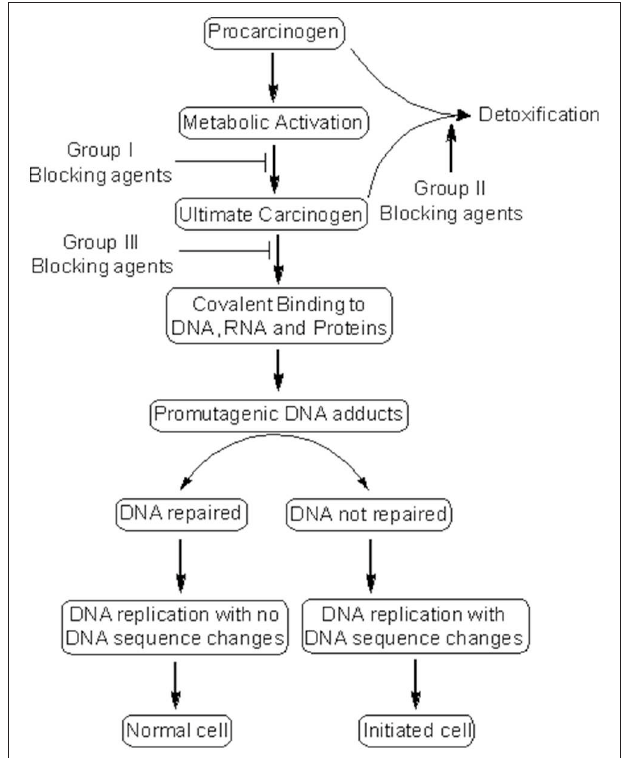
FIGURE 3 | Mechanism of cancer chemoprevention. Cancer chemopreventive agents can inhibit the metabolic conversion of procarcinogens to their ultimate reactive intermediates (group I blocking agents) and their subsequent interaction with DNA, RNA, and proteins (group III blocking agents). Alternatively, blocking agents can stimulate the detoxification of carcinogens (group II blocking agents), leading to their removal from the body. Other chemopreventive agents (suppressing agents) can suppress the later steps (promotion, progression) of cancer development. Some chemopreventive agents can behave as both blocking and suppressing